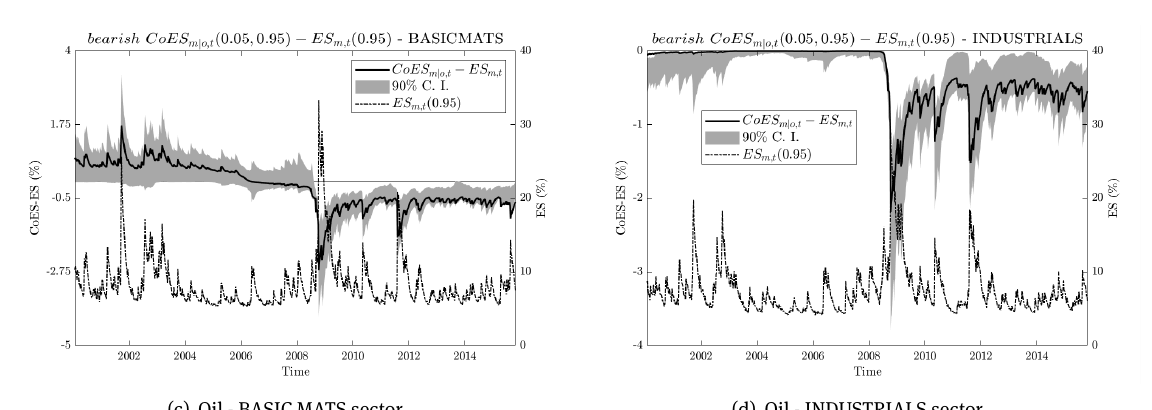
(0.05). Solid blue line shows this m , t